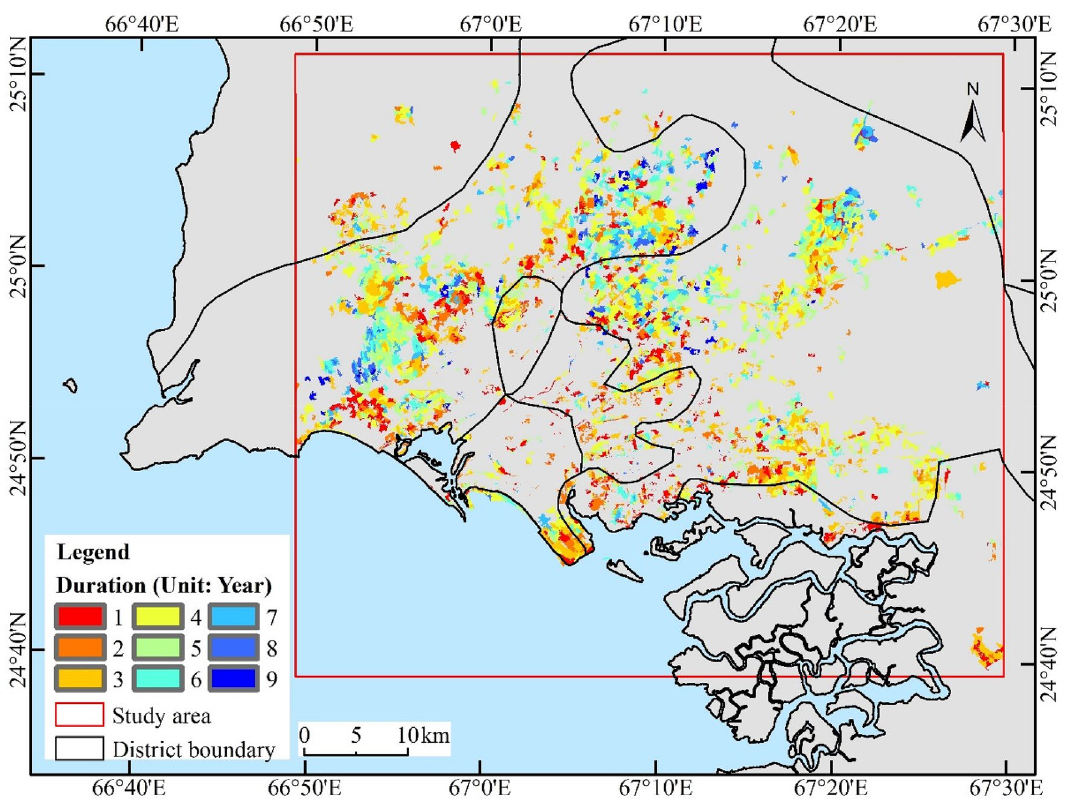
Figure 3. Duration of disturbance of newly added objects in urban built-up areas of Karachi. The map created in ESRI ArcMap 10.2 (https:// suppo rt. esri. com/ zh- cn/ produ cts/ deskt op/ arcgis- deskt op/ arcmap/ 10-2-2).